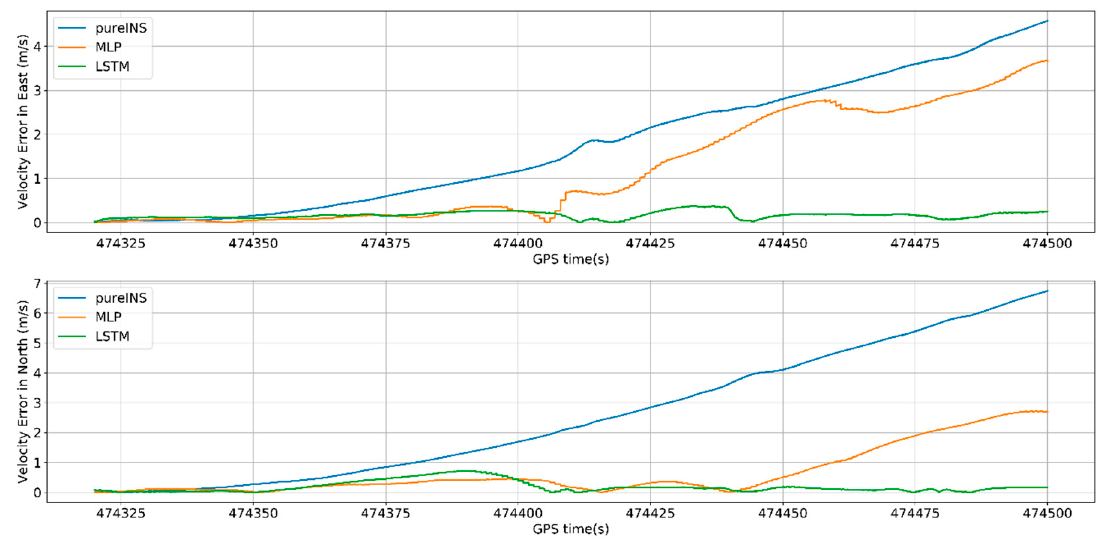
Figure 21. Velocity errors of 180 s outages with di ff erent algorithms.